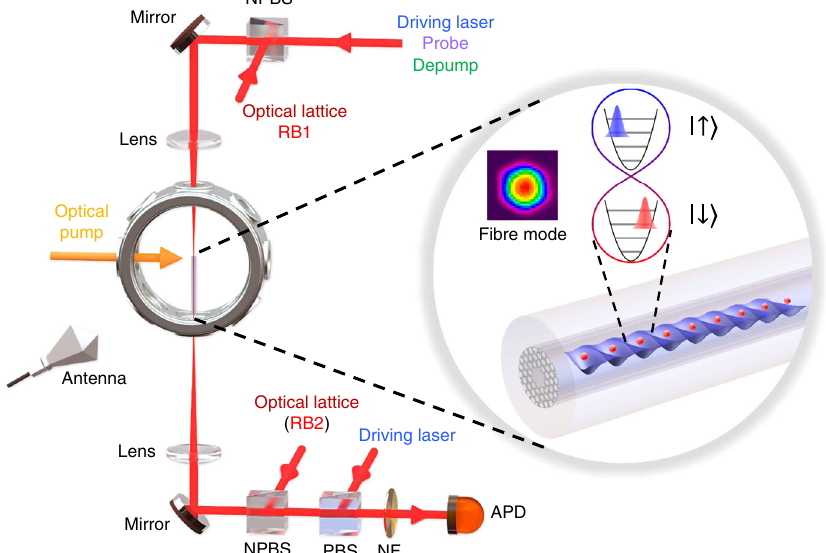
Fig. 1 Schematic of the experimental setup. Two 150-mm achromatic lenses are used to couple all the beams into the fi bre with 70% coupling ef fi ciency. The π -polarised optical pump beam incident from the side of the fi bre can ef fi ciently prepare atoms in the | F = 2, m = 0> state with >90% ef fi ciency. Each lattice site in the fi bre represents a harmonic oscillator potential for atoms (red fi lled circles). The coloured Gaussian wave packets in the potential illustrate the coherent harmonic oscillator states that are entangled with the spin states. The inset shows a near- fi eld image of the waveguide mode. PBS: polarising beam splitter. NPBS nonpolarising beam splitter, NF notch fi lter, APD avalanche